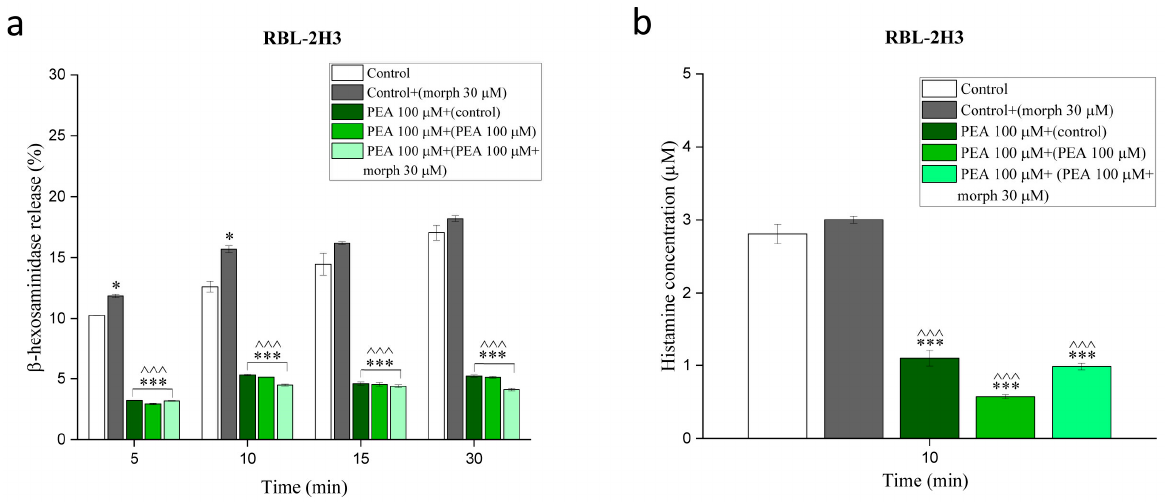
Figure 3. Effect of PEA on morphine-stimulated MC degranulation. RBL-2H3 sensitized with anti-DNP IgE 50 ng/mL and pre-treated with PEA 100 µ M for 18 h, incubated the next day with 30 µ M morphine, 100 µ M PEA, the combination of PEA and morphine and medium only, for 30 min, then stimulated with DNP-BSA for 5, 10, 15 and 30 min for β -hexosaminidase assay ( a ) and 10 min for histamine dosage in the medium by HPLC ( b ). DNP-BSA was used at a final concentration of 625 ng/mL in all experiments. Values are expressed as the mean ± S.E.M. of three experiments. * p < 0.05; *** p < 0.001 vs. control. ˆˆˆ p < 0.001 vs. control + (morphine 30 µ M).